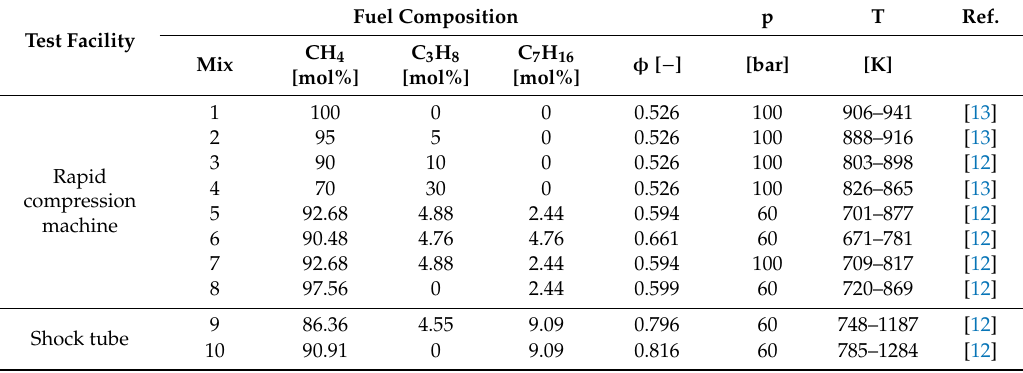
Table 1. Overview of the homogeneous mixtures used for the optimization of the reaction mechanism including the respective proportion of methane, propane and n -heptane in the mixture, each in mol%, the fuel–air equivalence ratio φ , the pressure p in bar, and the temperature T in